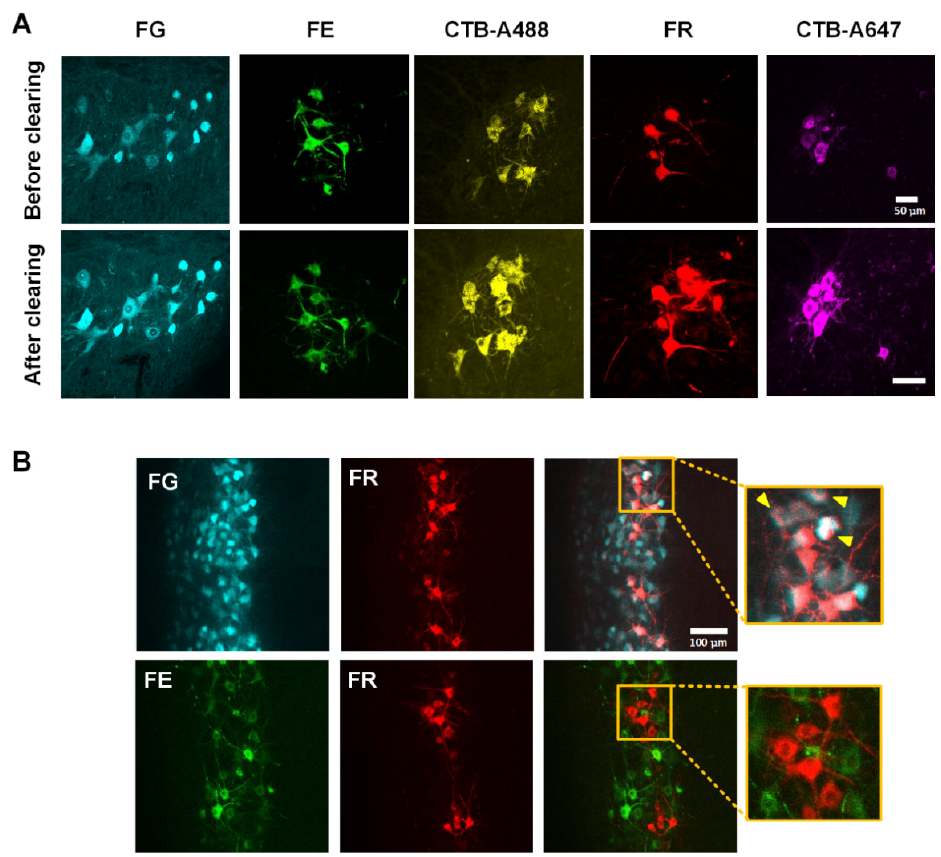
Figure 1. Screening of fluorescent dyes. ( A ) The median nerve was labeled with FE, FR, FG, CTB- A488, CTB-A647, GB, and RB, respectively. Confocal images of spinal cord sections show that FG, FE, CTB-488, FR, and CTB-647 can successfully label motor neurons, and they are compatible with 3DISCO method. ( B ) Multi-labeling of motor neurons corresponding to the median (FG or FE) and ulnar nerves (FR). The presence of co-labeled neurons was associated with FG’s extensive diffusivity, which made FG be excluded from practical application. Arrowheads: co-labeled neurons.